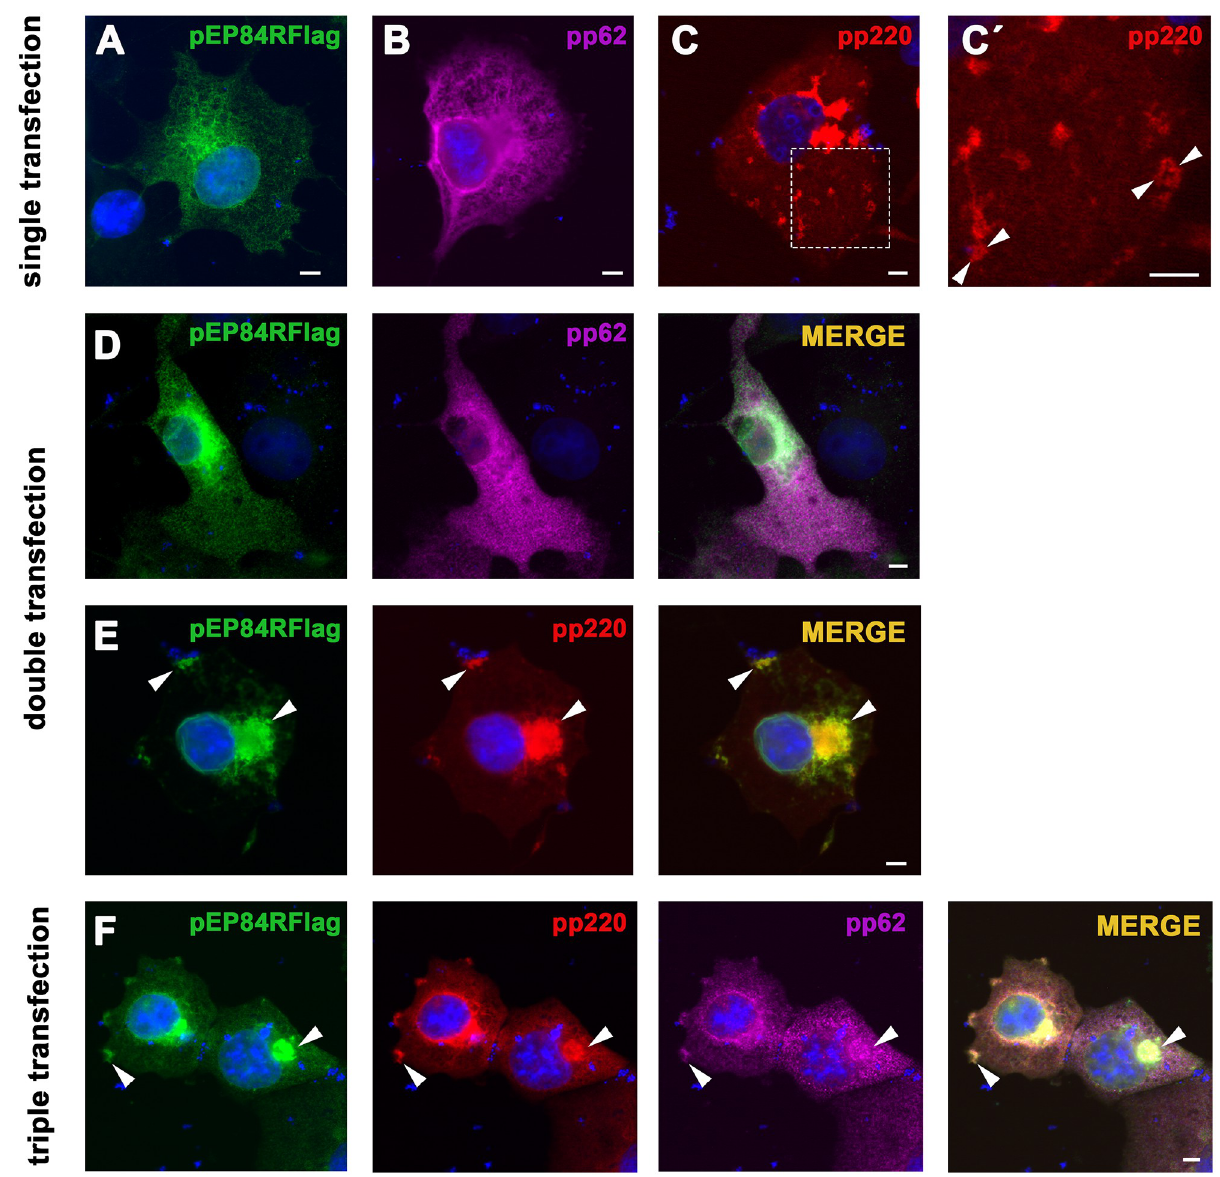
Fig 5. Protein pEP84R causes subcellular redistribution of polyprotein pp220. Transfected Cos cells expressing proteins pEP84R-Flag, pp62 and pp220 individually or in combination, were fixed and immunolabeled with rabbit antibodies to pEP84R (A, D and F) and pp220 (E) ; mouse mAbs to pp62 (B, D and F) , pp220 (C) and Flag tag (E) or rat antibody to pp220 (F) as indicated. Note that pp220 (C) outlines scattered cytoplasmic compartments (inset C´ ) when expressed individually. Instead, when co-expressed with pEP84R ( E) , both proteins colocalize to perinuclear areas and to a lesser extent to the cell surface (arrowheads). Note also the significant colocalization of pEP84R, pp220 and pp62 (F) at perinuclear areas and also at discrete PM patches (arrowheads). Bars, 10 μ